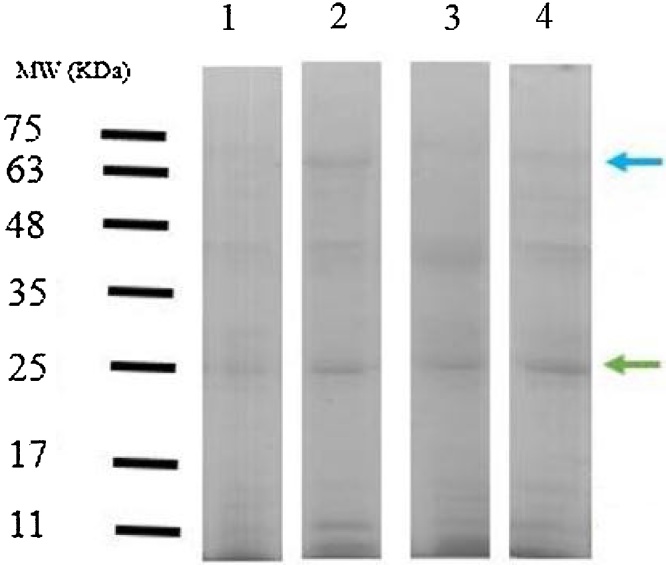
Evaluation of skin mucus protein profile using SDS-PAGE; the green arrow indicates a band with enhanced intensity; the blue arrow indicates a new band; Line 1: Control, Line 2: 3.75 mg /l, Line 3: 7.5 mg / l, Line 4: 15 mg / l lead.